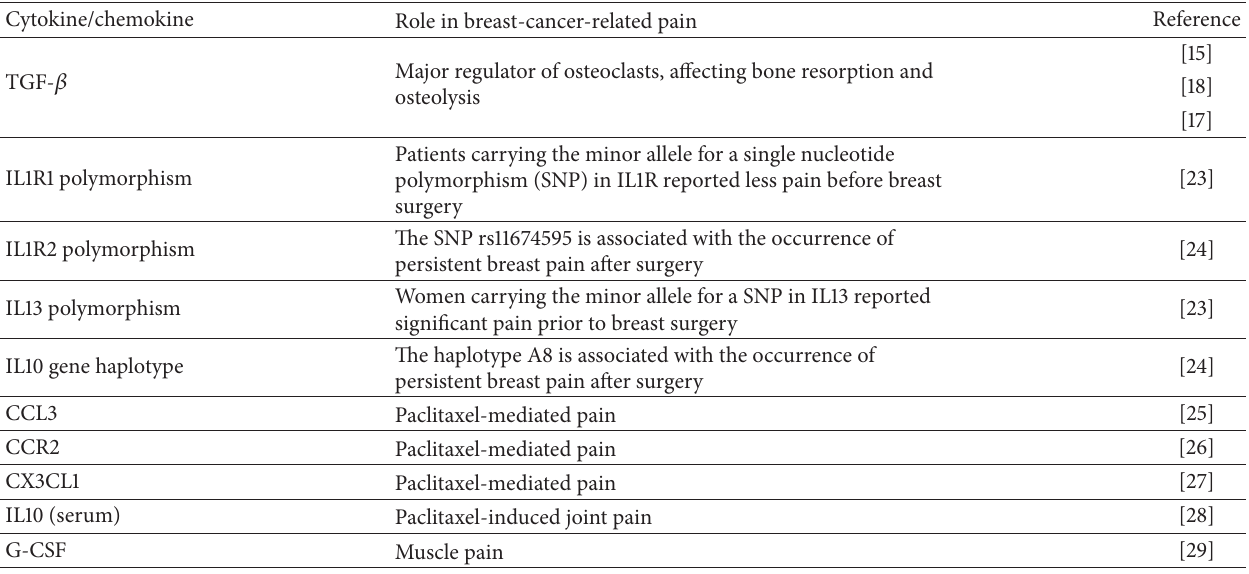
Cytokine/chemokine Role in breast-cancer-related pain Reference Major regulator of osteoclasts, affecting bone resorption